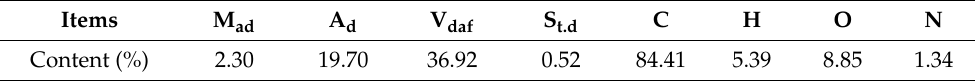
Table 1. Basic parameters of tectonic coal *.